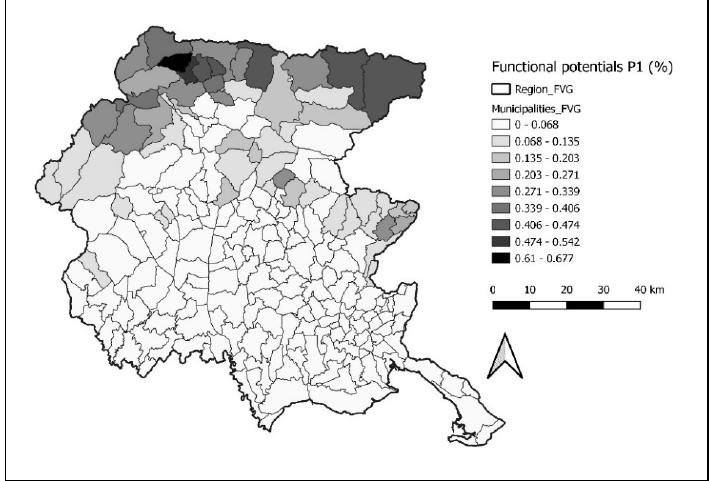
Figure 5. Potential respiratory benefits by regional forests in mountain municipalities: General-holistic approach (P1). Source: authors.